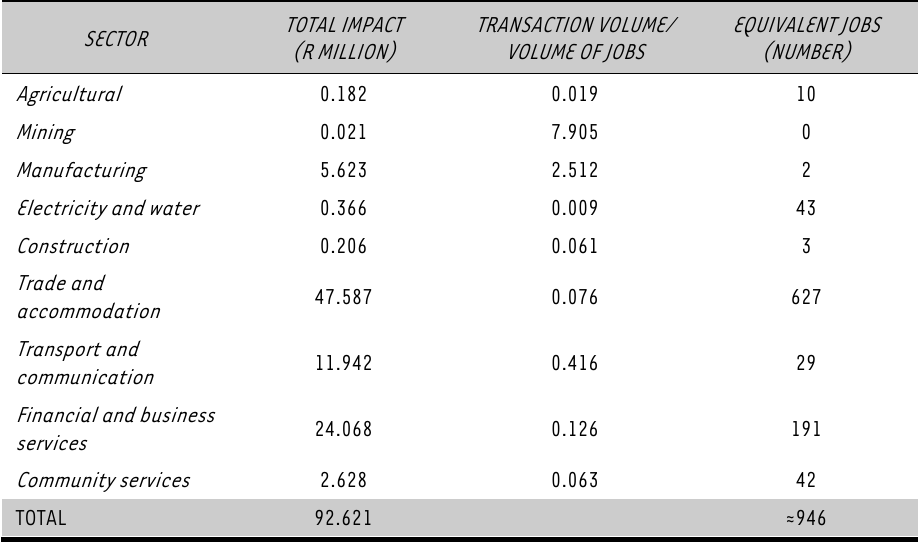
The regional impact of the KKNK on the level of